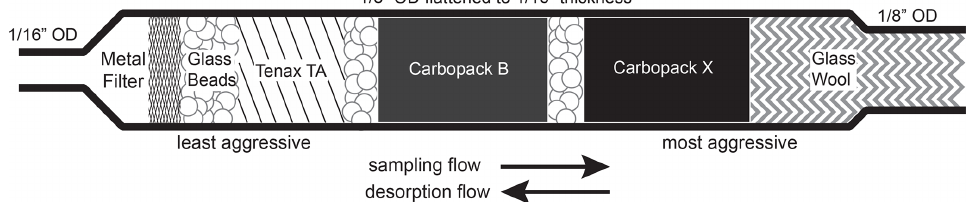
Figure 2. Schematic of I/VOC collector. Semivolatile and lower-volatility species, including particles, are captured on the metal filter. IVOCs are captured on the Tenax TA, while the most volatile analytes including isoprene are retained by the more aggressive adsorbents. Flow is reversed for desorption so that the less volatile compounds never interact with the more aggressive